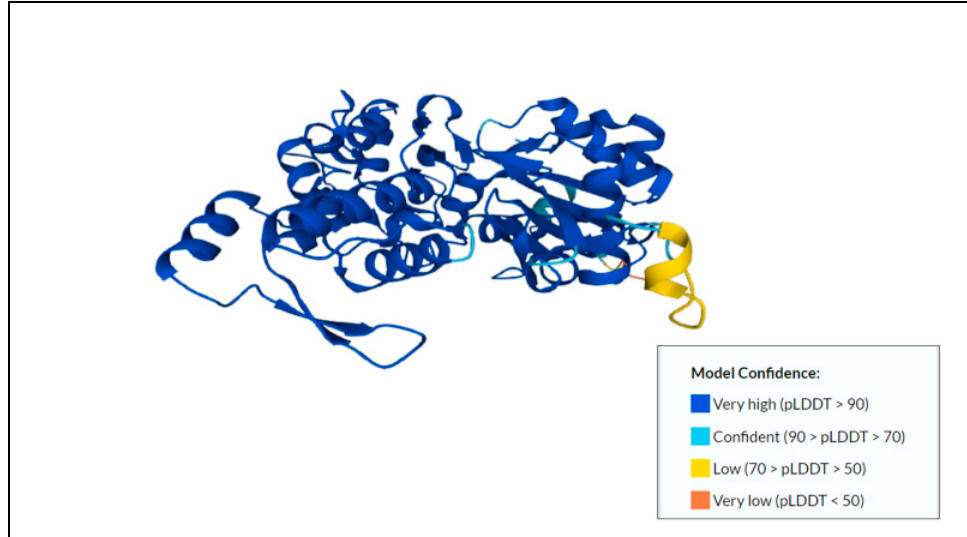
Figure 8. Predicted protein structure of actin [41,99,102] (https://www.uniprot.org/uniprotkb/P11426/entry, accessed on 25 October 2022).